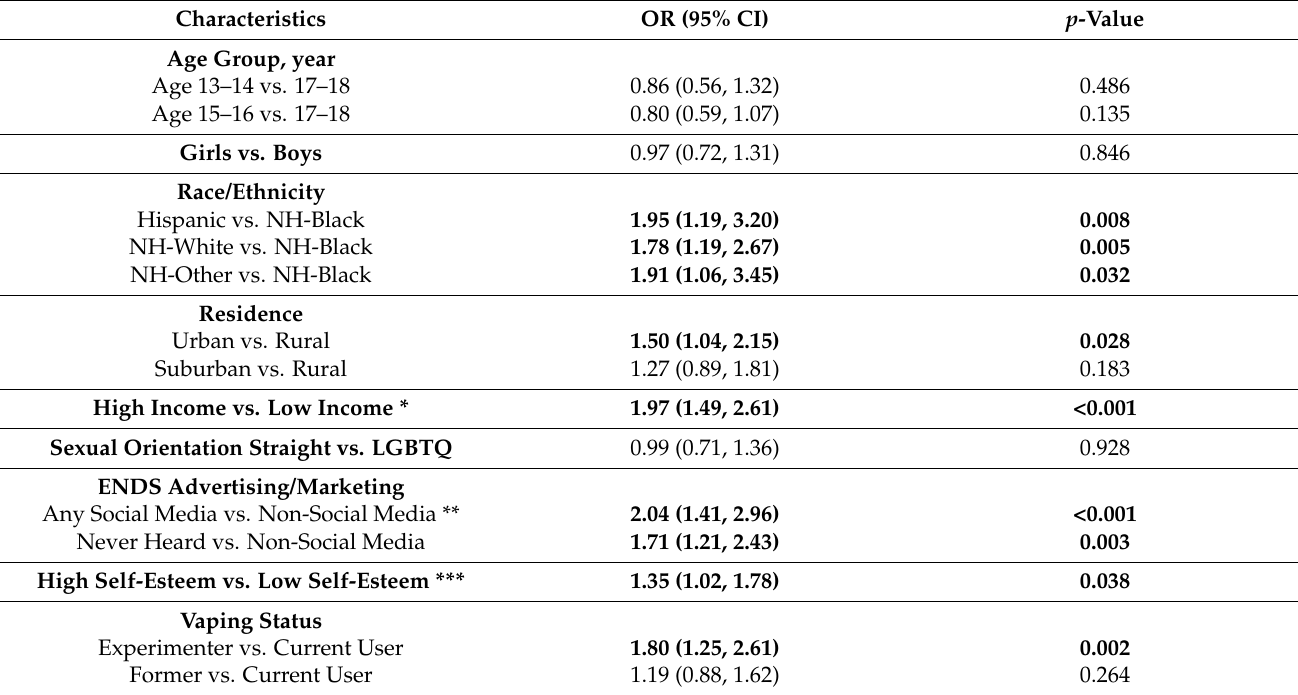
Table 4. Multivariable Adjusted Odds Ratios (95% CI) of Friends as Source of First ENDS Product – Quantitative Survey.